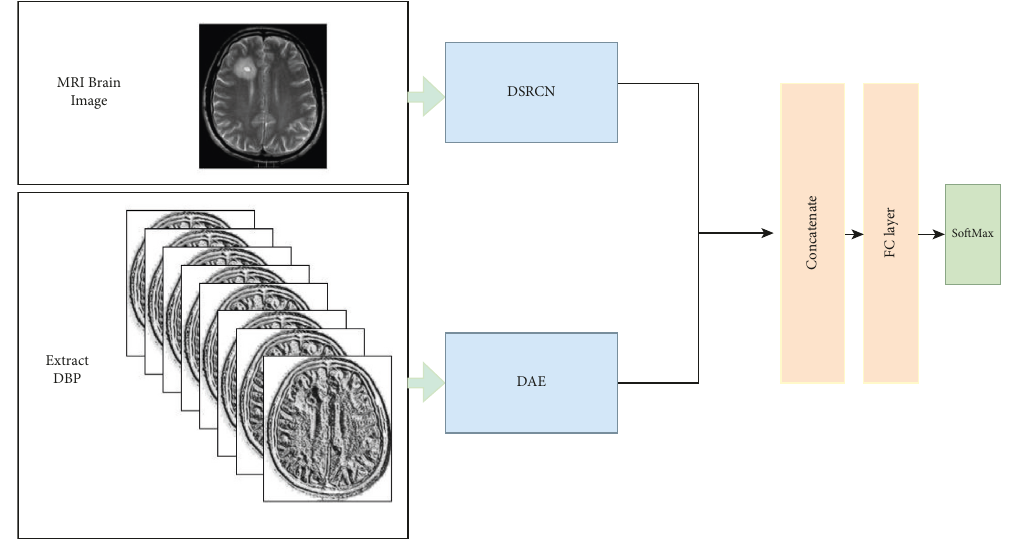
Figure 5: Deep learning framework of the proposed multibranch model.